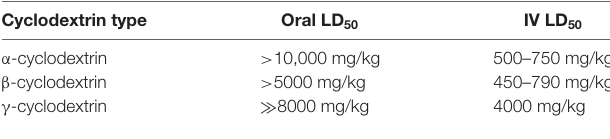
TABLE 1 | Toxicology of naturally occurring cyclodextrins in the rat (compiled from Del Valle, 2004). Cyclodextrin